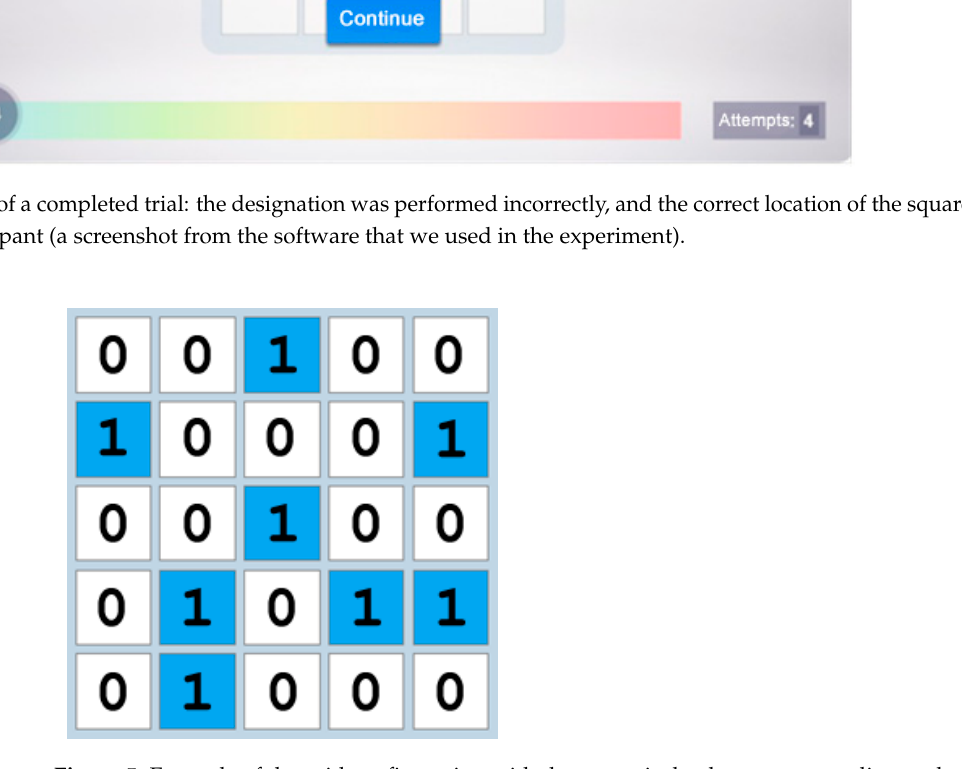
Figure 5. Example of the grid configuration with the numerical values corresponding to the cells.